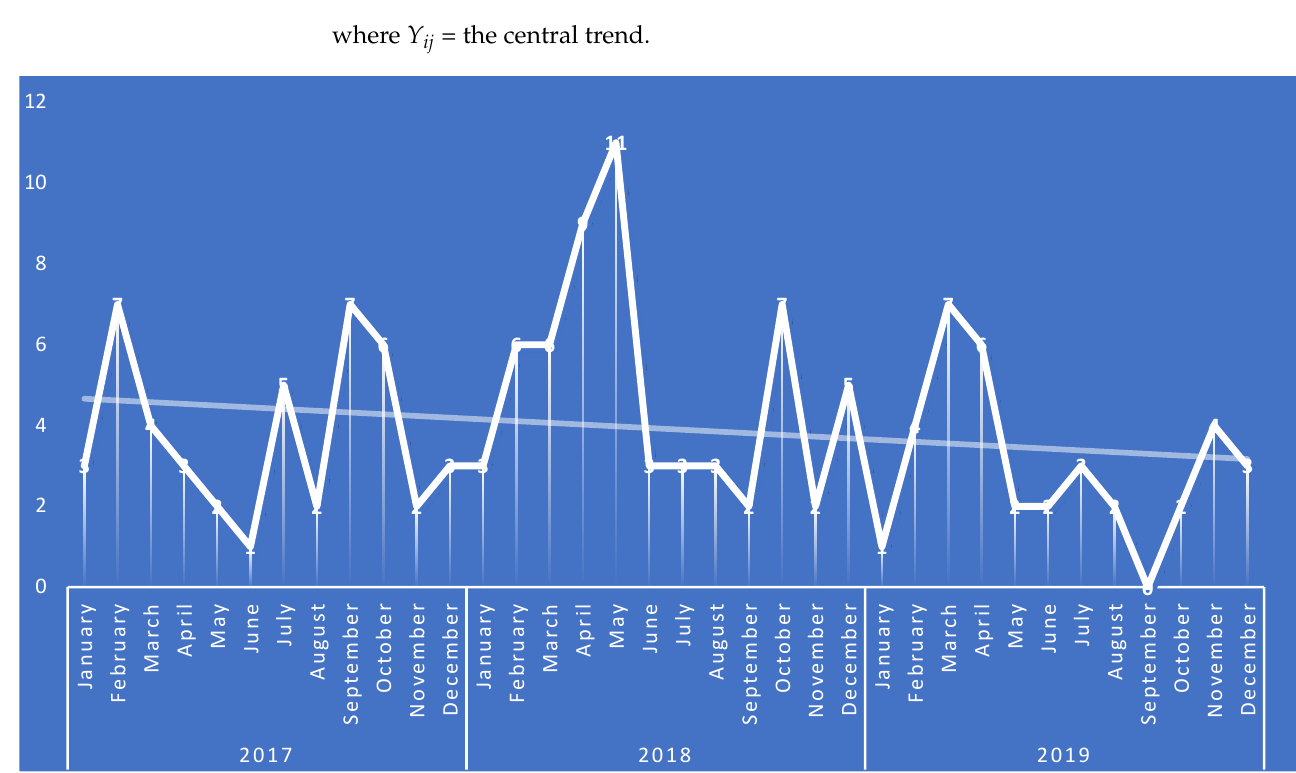
Figure 1. The number of oil-pipeline-related incidents in Romania for years 2017 to 2019 containing the chronogram and seasonality for incidents per month.